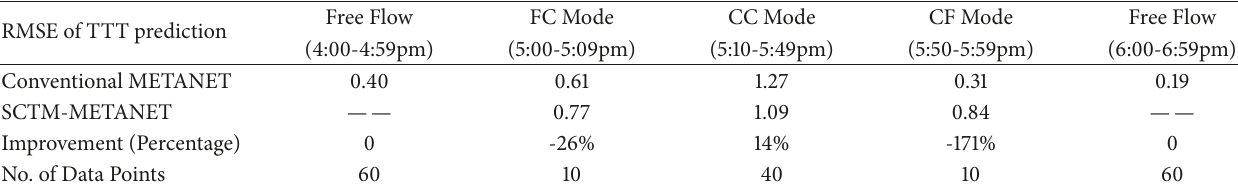
Table 2: Quantitative comparison of METANET and SCTM-METANET models: TTT.